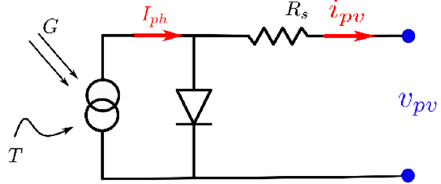
Figure 1. Equivalent circuit model of a PV.